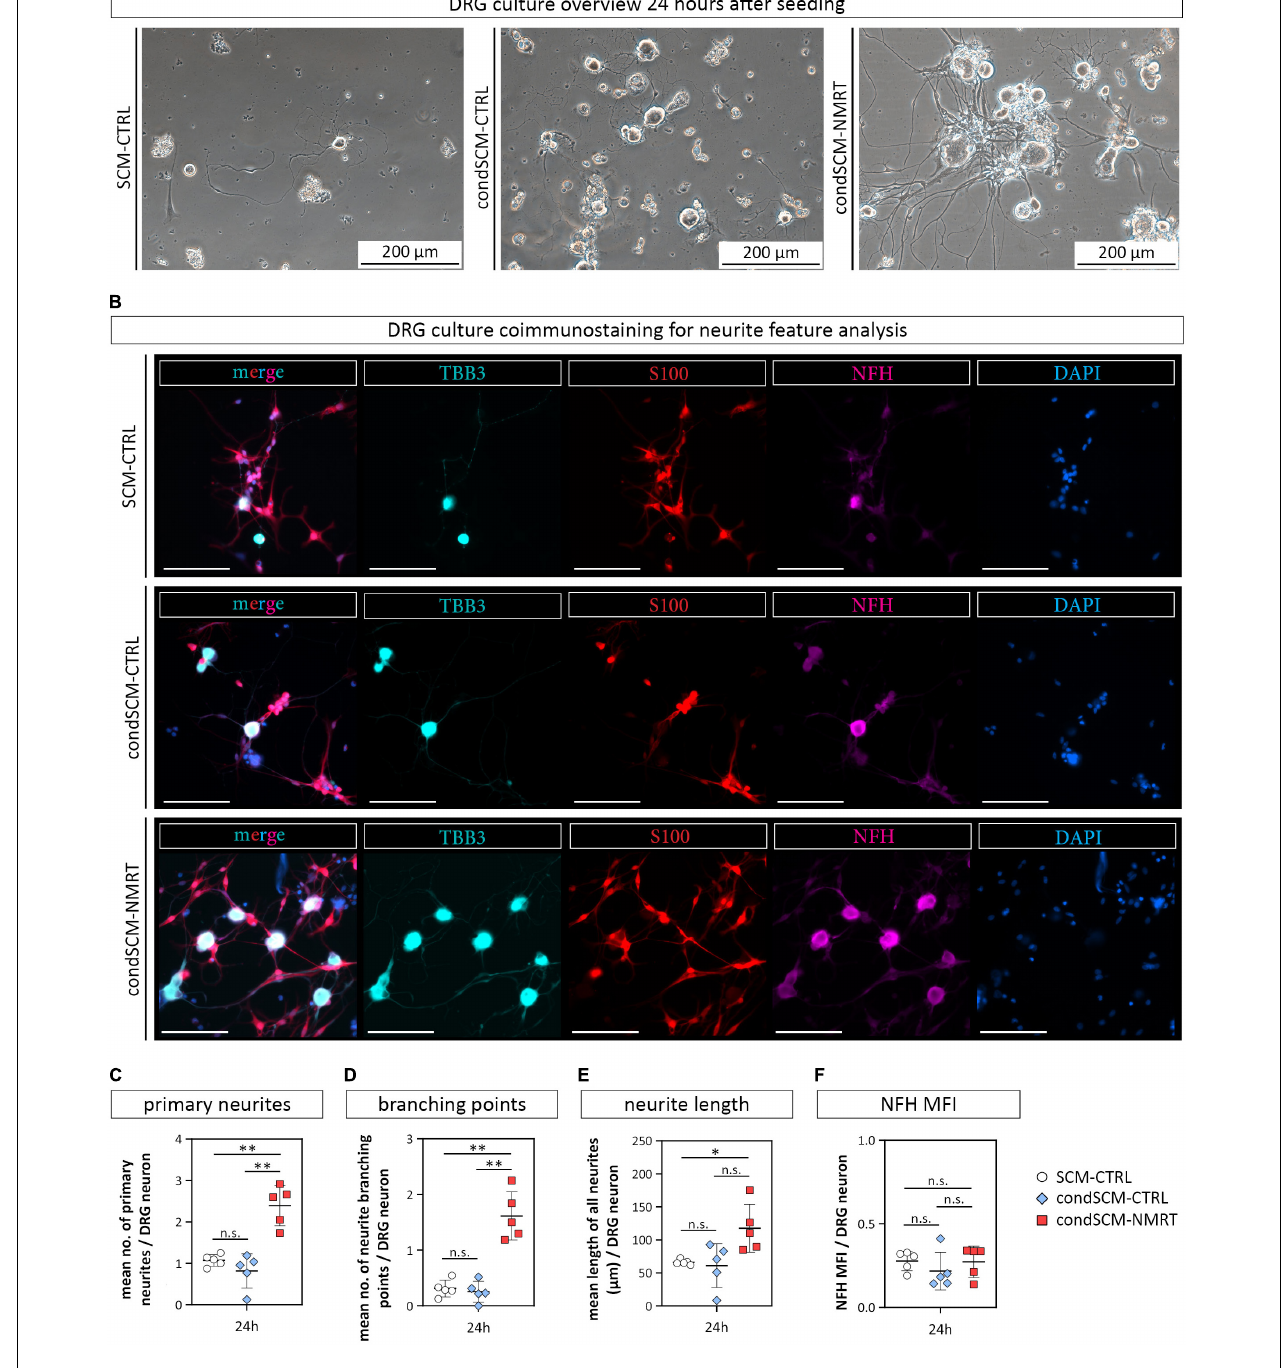
FIGURE 7 | Comparison of DRG cultures and their neurite features in response to conditioned medium derived from NMRT treated SC cultures. (A) Representative phase contrast images show DRG cultures 24 h after seeding in either SCM-CTRL (left image), condSCM-CTRL (middle image), and condSCM-NMRT (right image). (B) Representative immunofluorescence images of DRG cultures 24 h after seeding in SCM-CTRL (upper panel), condSCM-CTRL (middle panel), and condSCM-NMRT (lower panel) stained for TBB3 (cyan), S100 (red), NFH (magenta), and DAPI (blue). Scale bars represent 100 µ m. Quantification of (C) the mean number of primary neurites per DRG neuron, (D) the mean number of neurite branching points per DRG neuron, (E) the mean length of neurites per image (field of view), and (F) NFH mean fluorescence intensity (MFI) per DRG neuron (F) ; data are depicted as single values for each donor ± SD ( n = 5), two-way ANOVA, ∗∗ p < 0.01, ∗ p < 0.05, n.s. not